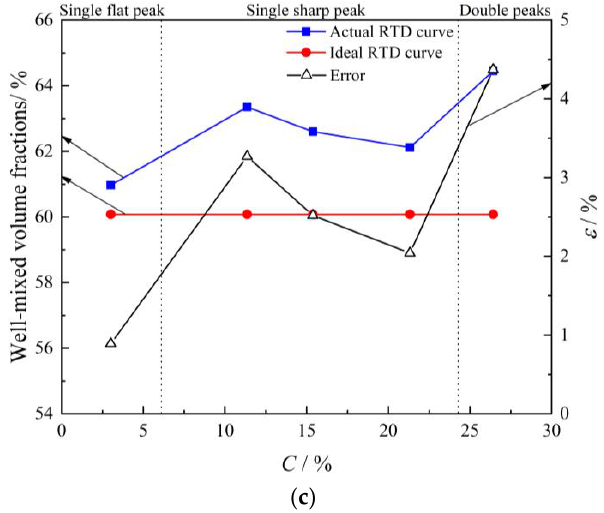
Figure 8. RTD curves analysis result by different tracer mass concentrations: (a) plug volume; (b) dead volume; (c) well-mixed volume. Table 7. RTD curves analysis results in the case of different tracer